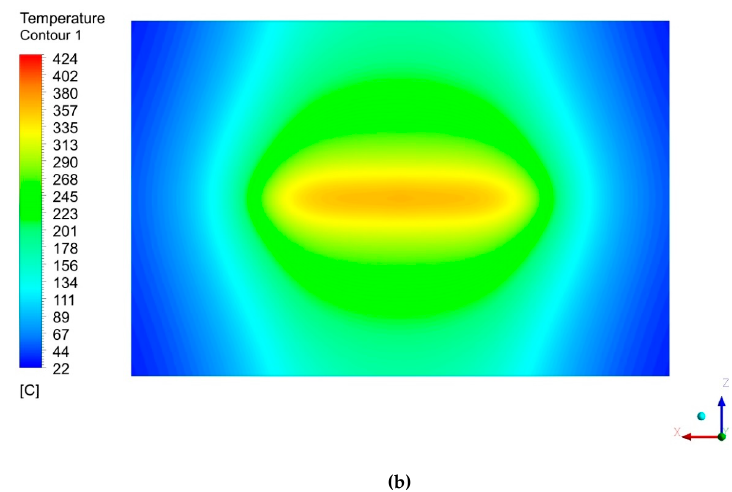
Figure 8. Temperature contours at the bottom surface of the steel plate for two models at the operating conditions of Φ = 1, Re = 3483, and Y/d = 50: ( a ) With guide vanes; ( b ) without guide vanes. Energies 2019 , 12 , x Figure 9 shows the simulation results of the species mole fraction and temperature variations of the stoichiometric LPG/air mixture with respect to the main jet flow direction. Before combustion, in the unburned mixture at 27 ° C (300 K), the mole fractions of C 3 H 8 , C 4 H 10 , and O 2 were approximately 0.01, 0.02, and 0.2, respectively. After combustion, the mole fraction of the reactants decreased quickly. CO 2 and H 2 O were generated as products, and their mole fractions increased quickly. The flame temperature increased promptly for a short axial distance (Y/d = 6) when the combustion happened.